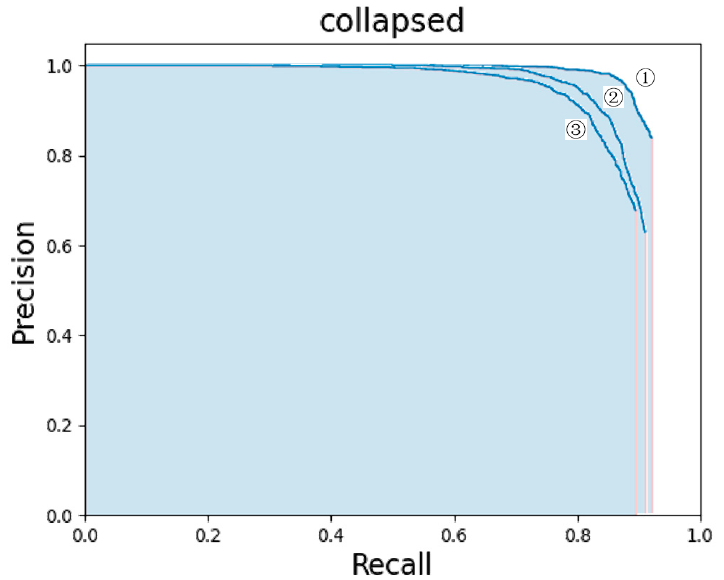
Figure 6. Comparison of three model precision-recall curves. ① : YOLOv4+ResNext+Focal-EIOU Loss. ② : YOLOv4+ResNext. ③ : YOLOv4.